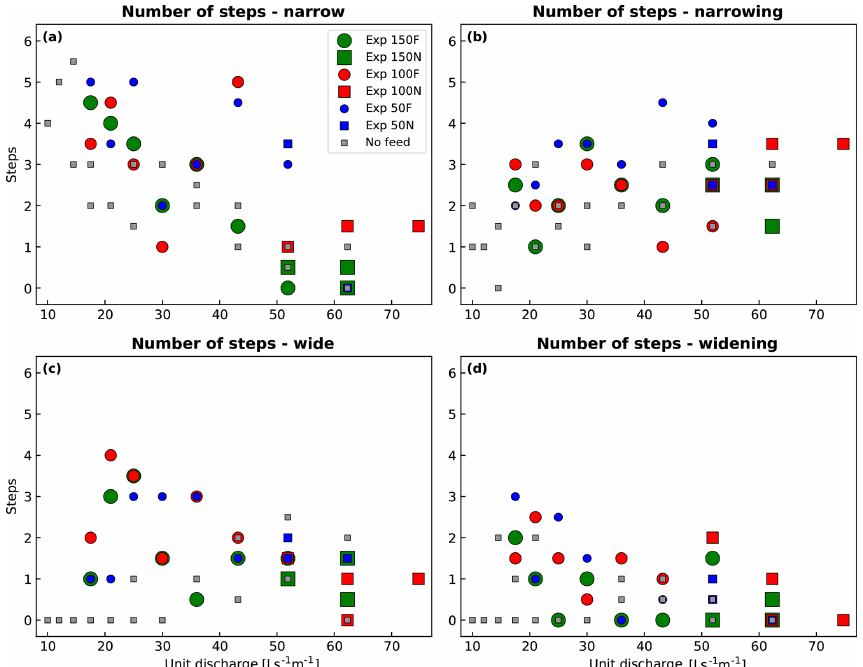
Figure 5. Number of steps detected in the feed and in the no-feed experiments at the end of each hour in (a) narrow segments, (b) narrowing segments, (c) wide segments, and (d) widening segments. Portions of experiments with sediment feed are shown with circles, while portions without sediment feed are shown with